Question: Write a single sentence explaining what this figure depicts.
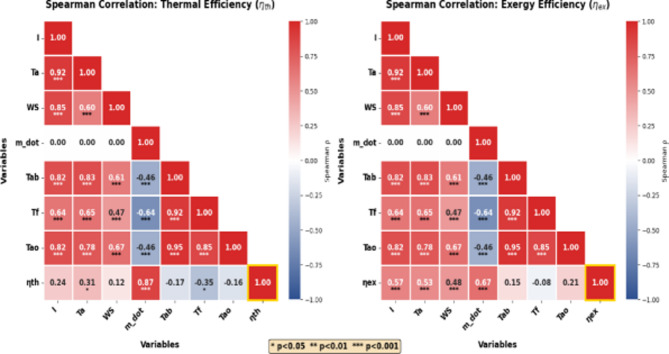
Answer: Spearman heatmaps for thermal and exergy efficiencies.